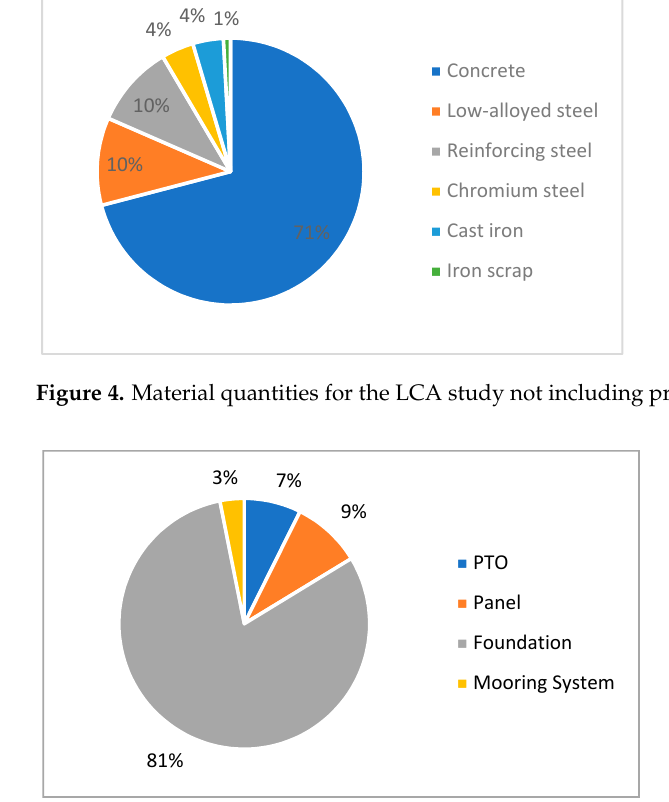
Figure 5. Mass breakdown by component.